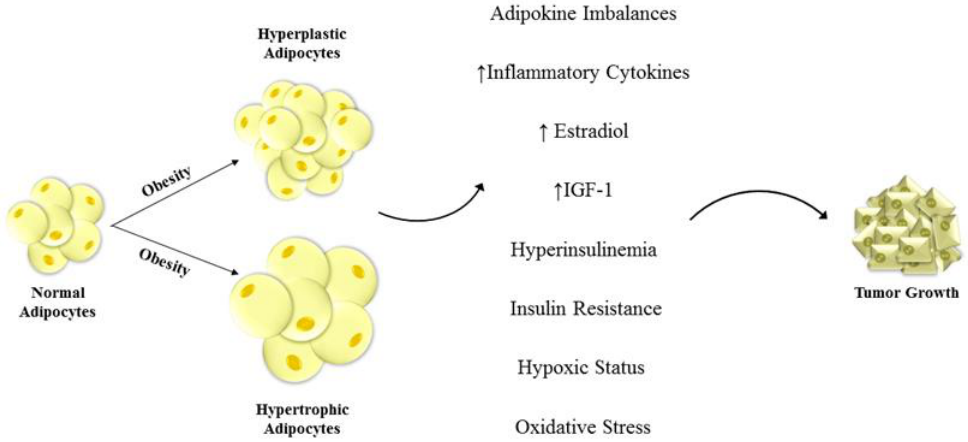
Figure 1. Unraveled mechanisms linking obesity and cancers. Hyperplastic and hypertrophic adipocytes are one of the main features of obesity. This dis-regulation of fat cells leads to change in adipokine and inflammatory cytokine secretion, enhanced insulin-like growth factor-1 (IGF-1) and estradiol production, and to hyperinsulinemia, insulin resistance, hypoxic status and oxidative stress. These alterations in the tumor microenvironment deeply impact the phenotype of the surrounding cells inducing severe modifications in cell behavior that contribute to tumor development and progression.